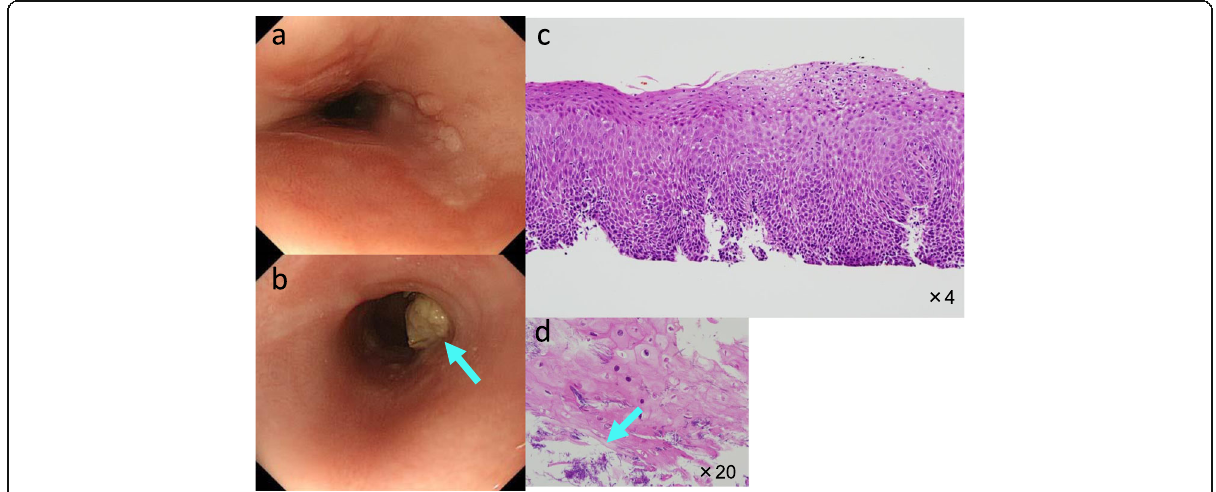
Fig. 3 Endoscopic examination 1 year later. a , b Polypoid lesions with fungal infection appeared on the erosive lesion (arrows). c Malignant findings were not recognized at biopsy specimens. d Fungal infection was observed on the epithelial surface of the biopsy specimens (arrows)